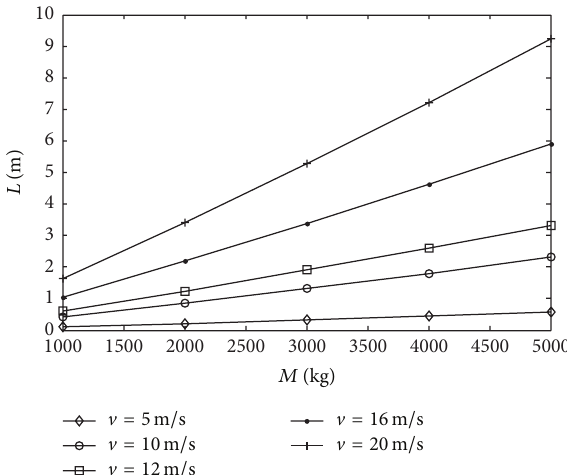
Figure 8: Tramcar braking distance change curves of different mass.